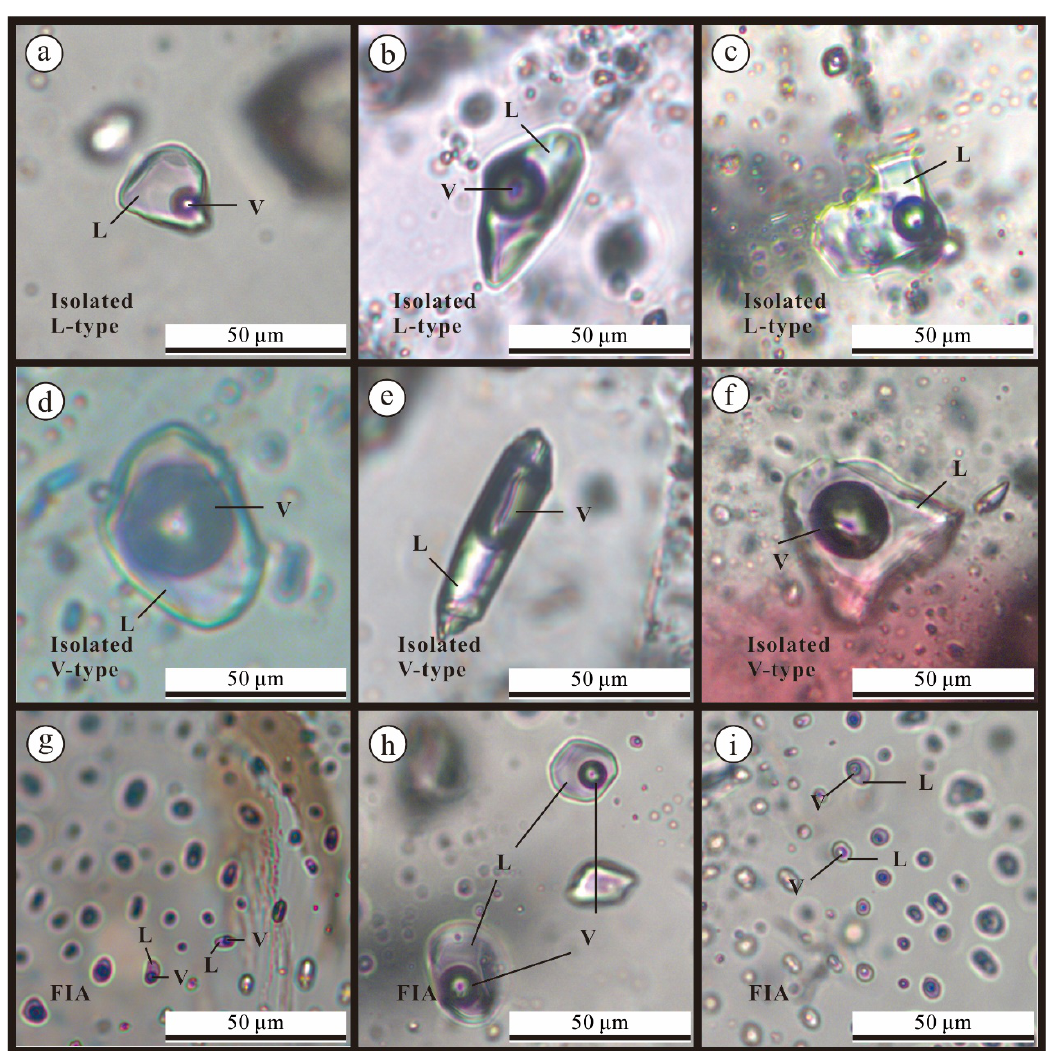
Figure 7. Microphotographs of fluid inclusions in quartz and fluorite from the Hongqiling Sn-W polymetallic deposit. ( a – c ) Isolated L-type inclusion; ( d – f ) isolated V-type inclusion; ( g – i ) a cluster of FIs with similar heating-freezing behavior, which together represent a fluid inclusion assemblage (FIA).